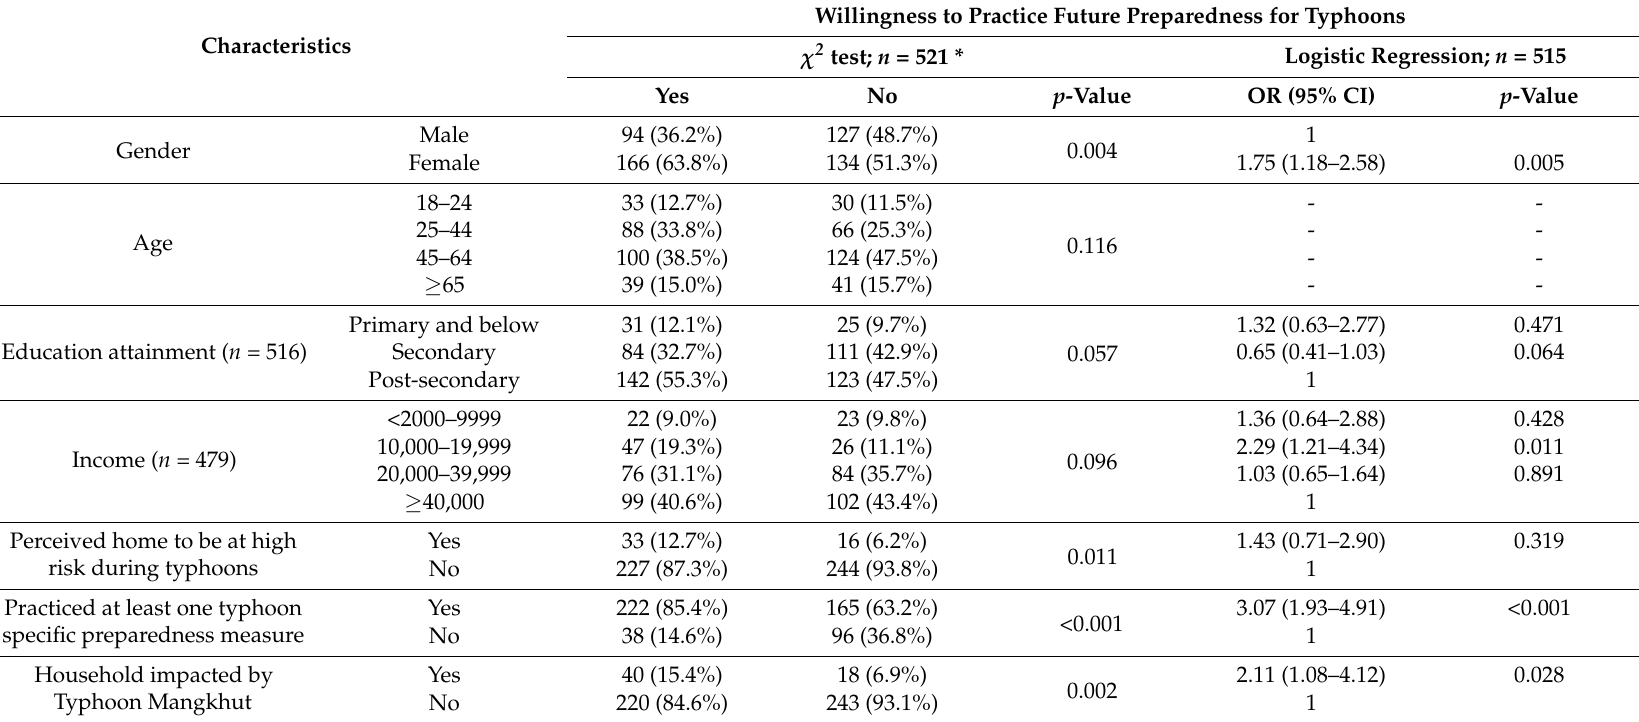
Table 5. The multivariable logistic regression for willingness to prepare for future